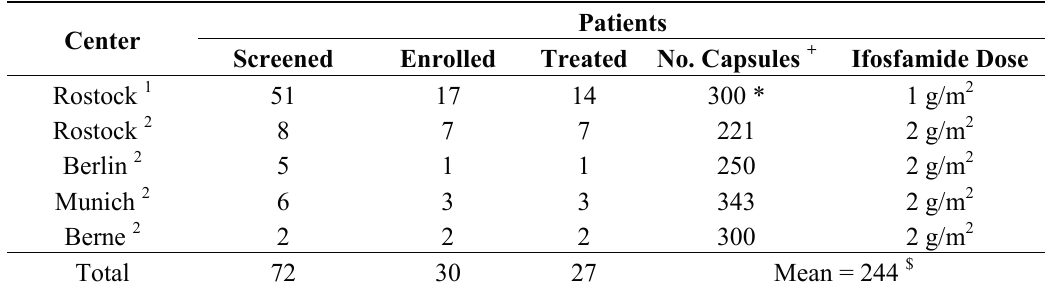
Table 2. Patient overview from the two clinical